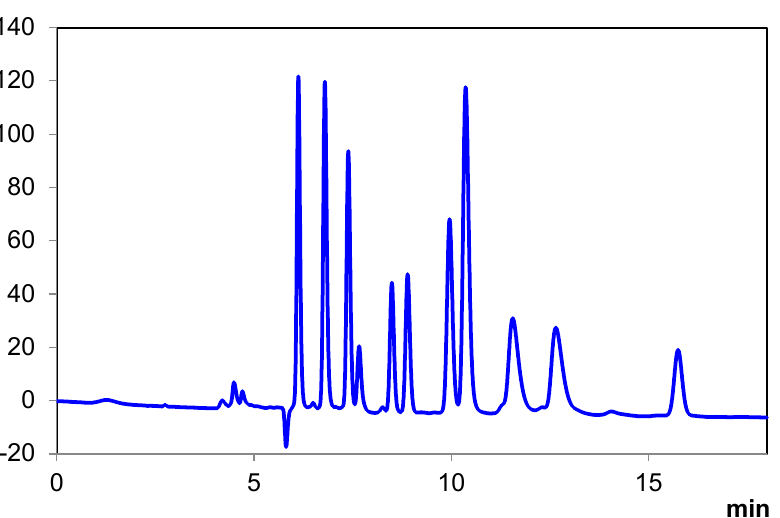
Figure 2. Ten-cannabinoid mixture separation under normal-phase conditions with Chiralpak IB- U.